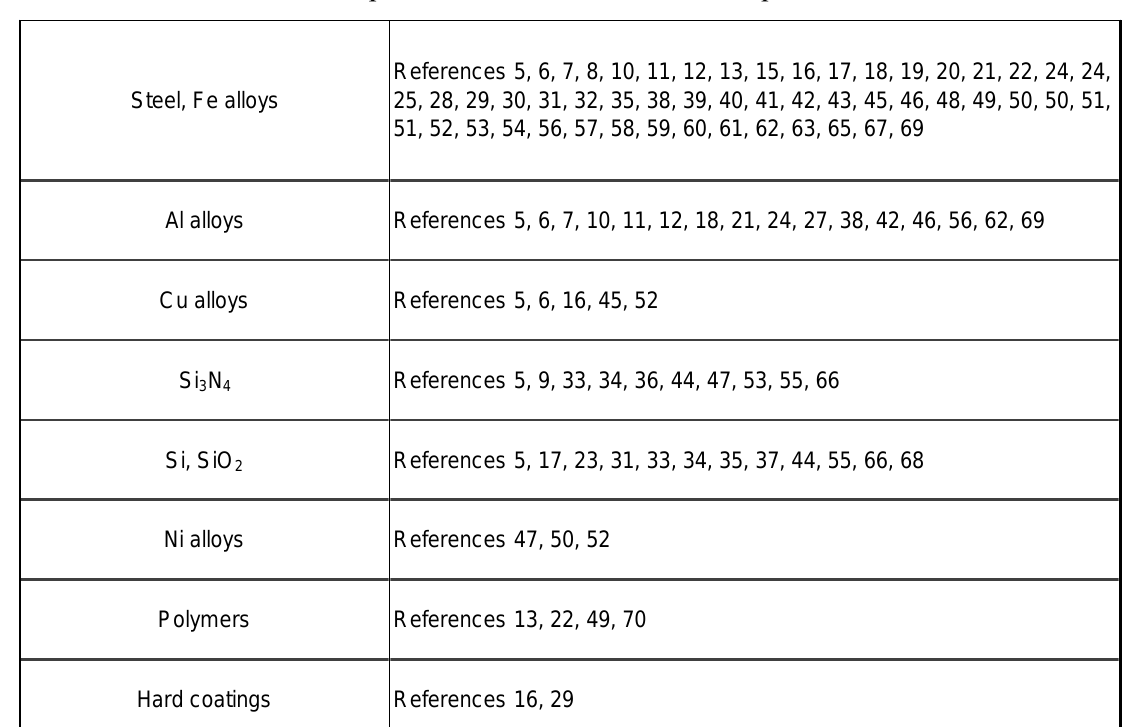
Table 2. Reported tribo-material for ionic liquid